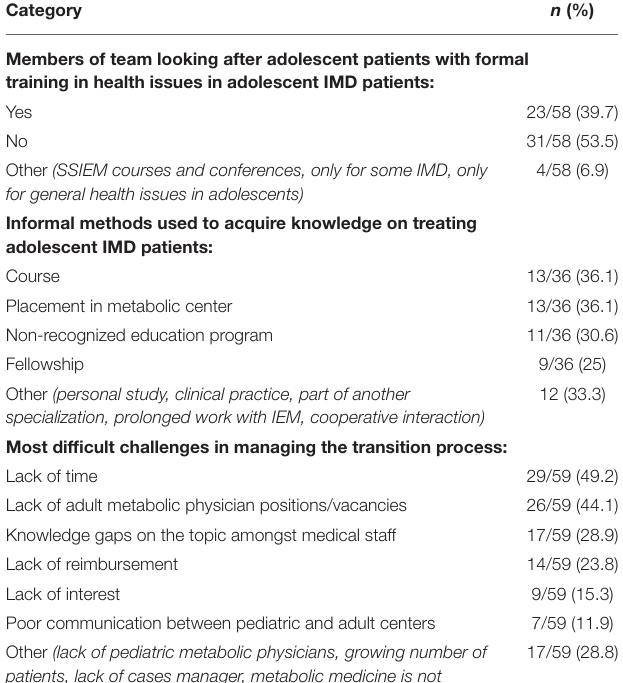
TABLE 4 | Shortcomings, challenges and needs related to transition.